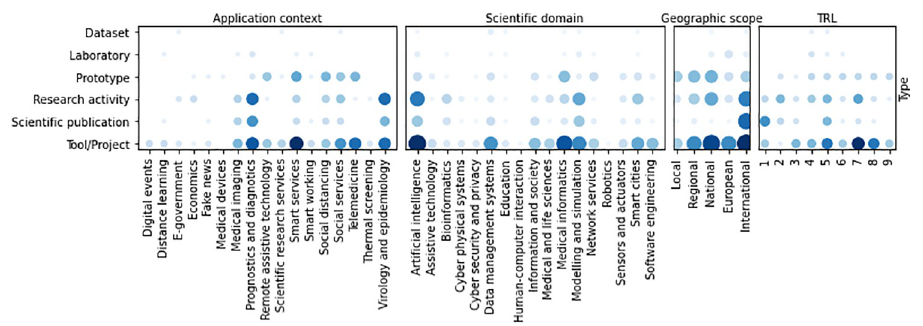
Fig 15. Co-occurrence of type of initiatives with the other